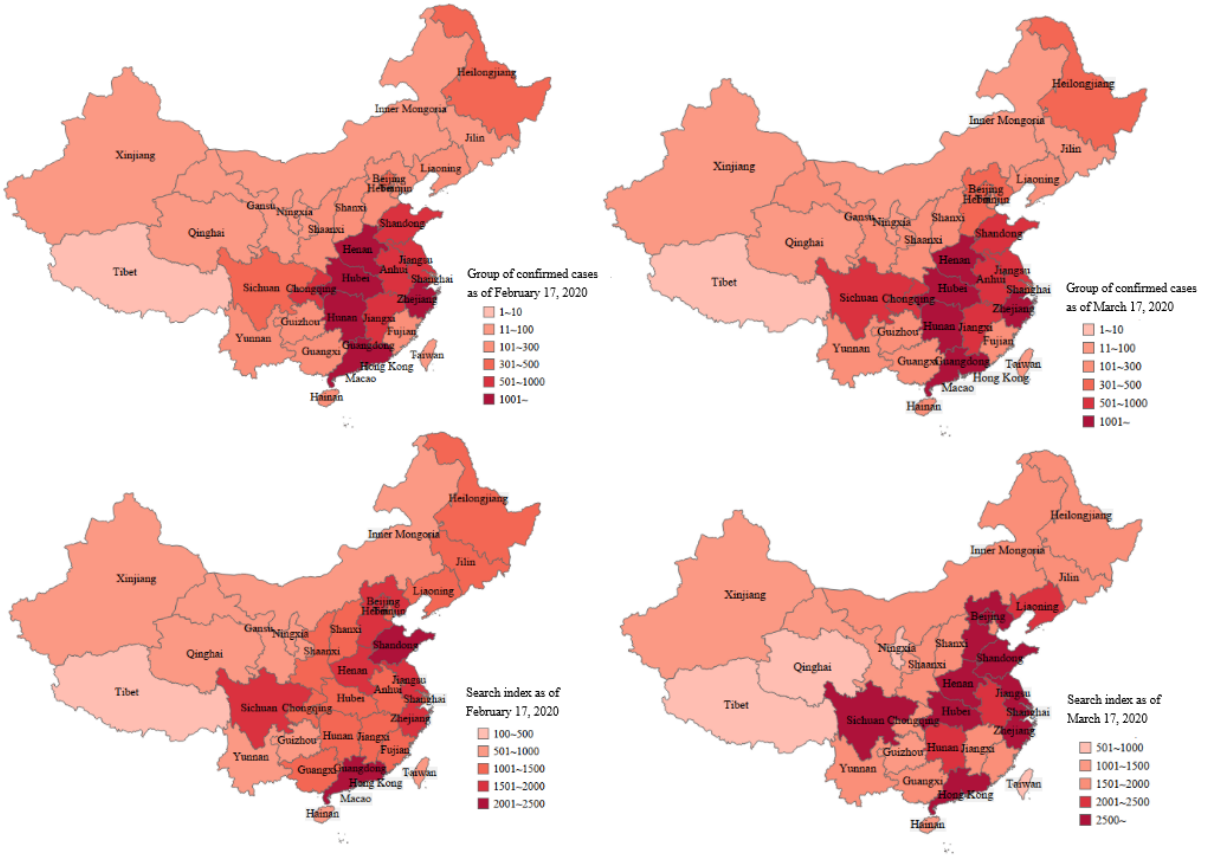
Figure 1. The cumulative number of confirmed cases of coronavirus disease (COVID-19) (top row) and the change in COVID-19's search index (bottom row) in